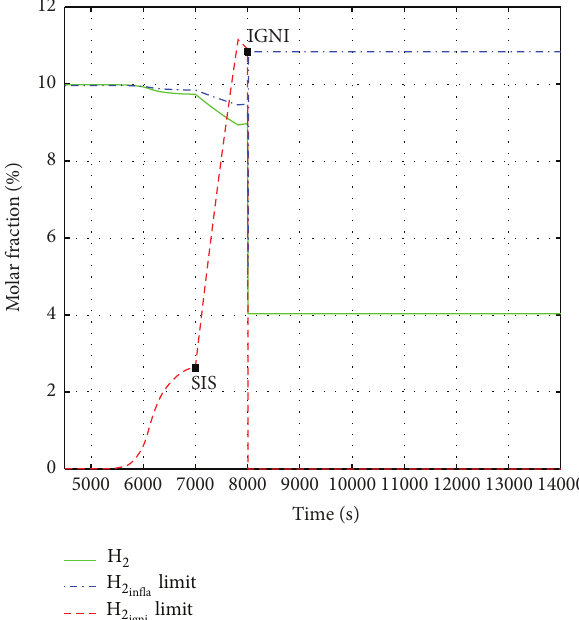
Figure 9: H 2 molar fraction (%) and H 2 inflammability and ignition limits (%).